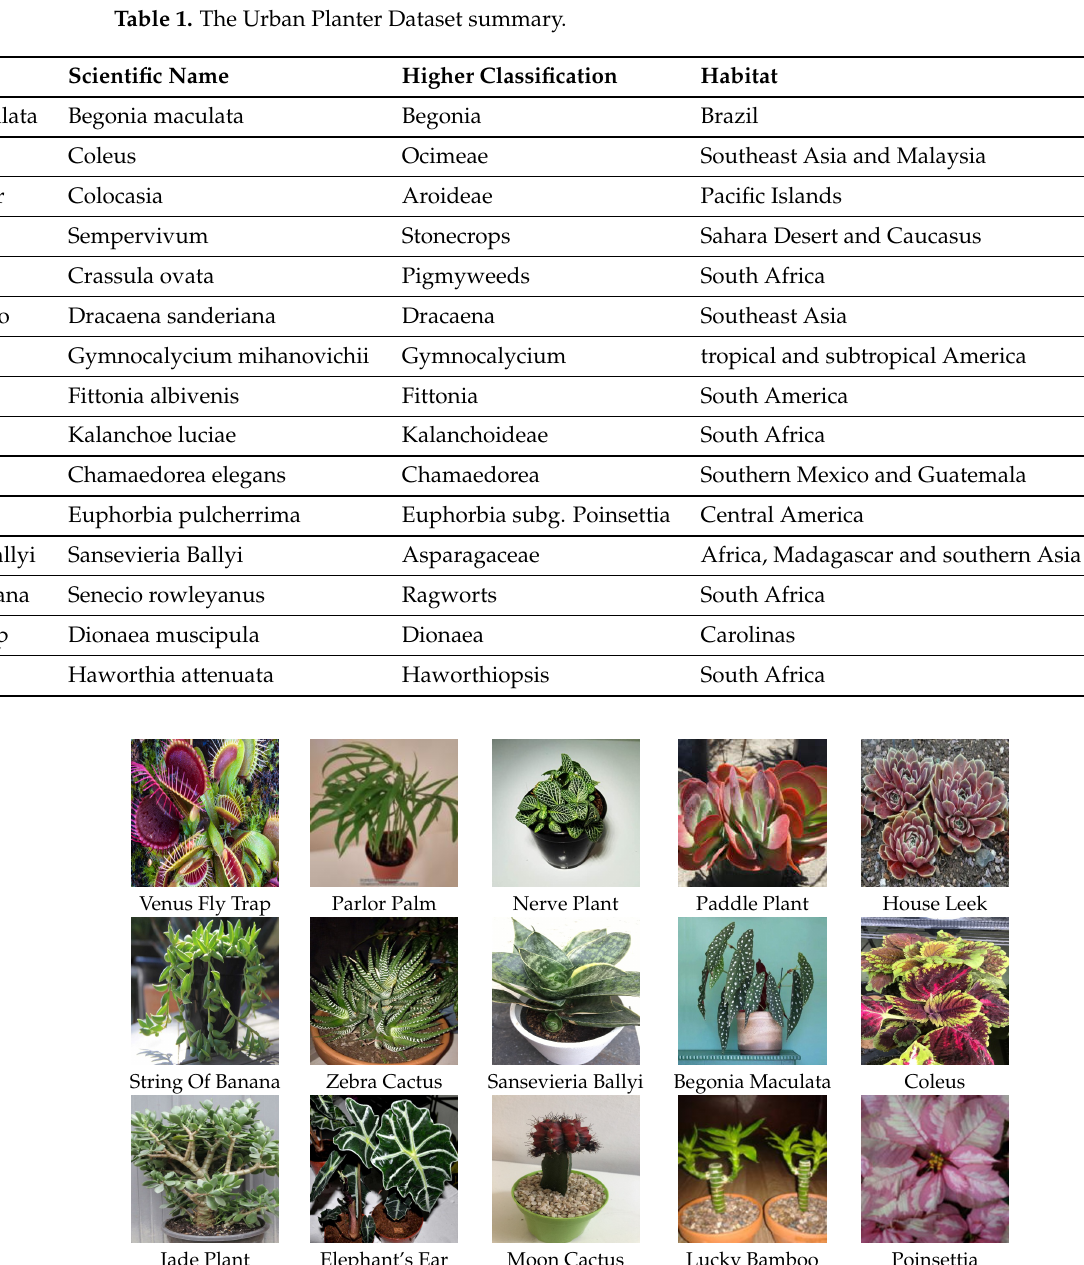
Figure 1. Examples of the fifteen species from the Urban Planter dataset. Note the similarity between Paddle Plant and House Leek (top row, right), and between Coleus and Poinsettia (the middle and last images in the last